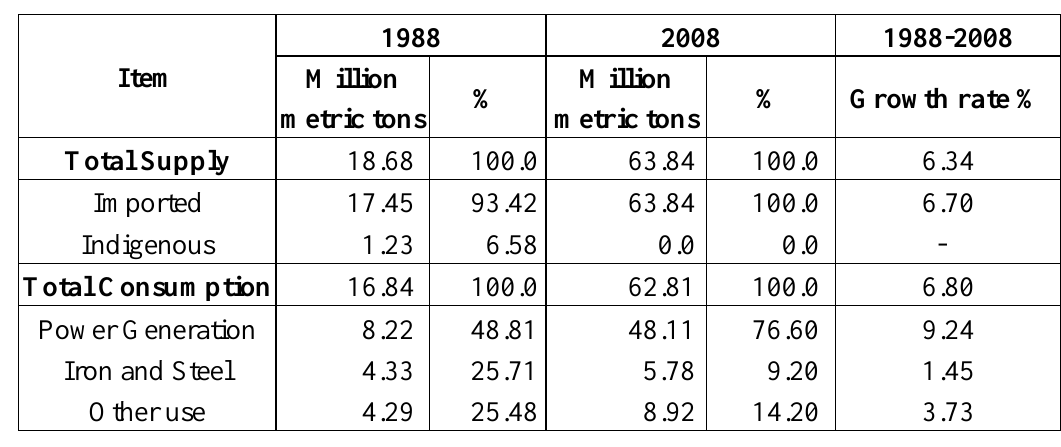
Table 1. Coal supply and consumption [5].